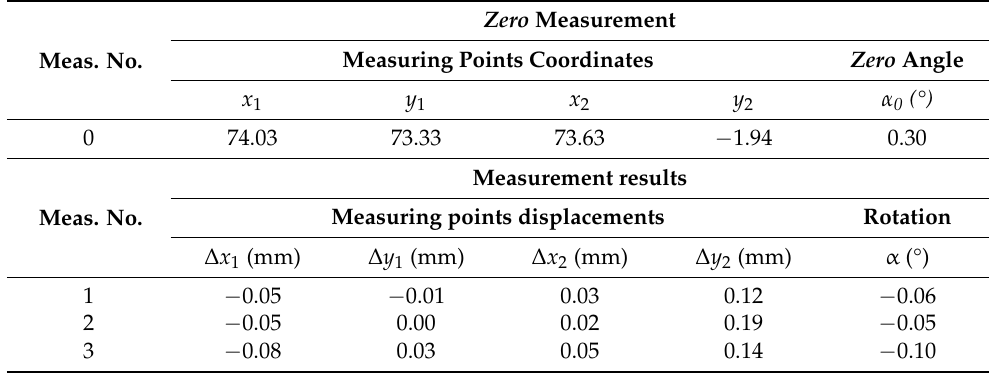
Table 8. Crack B measurement results.